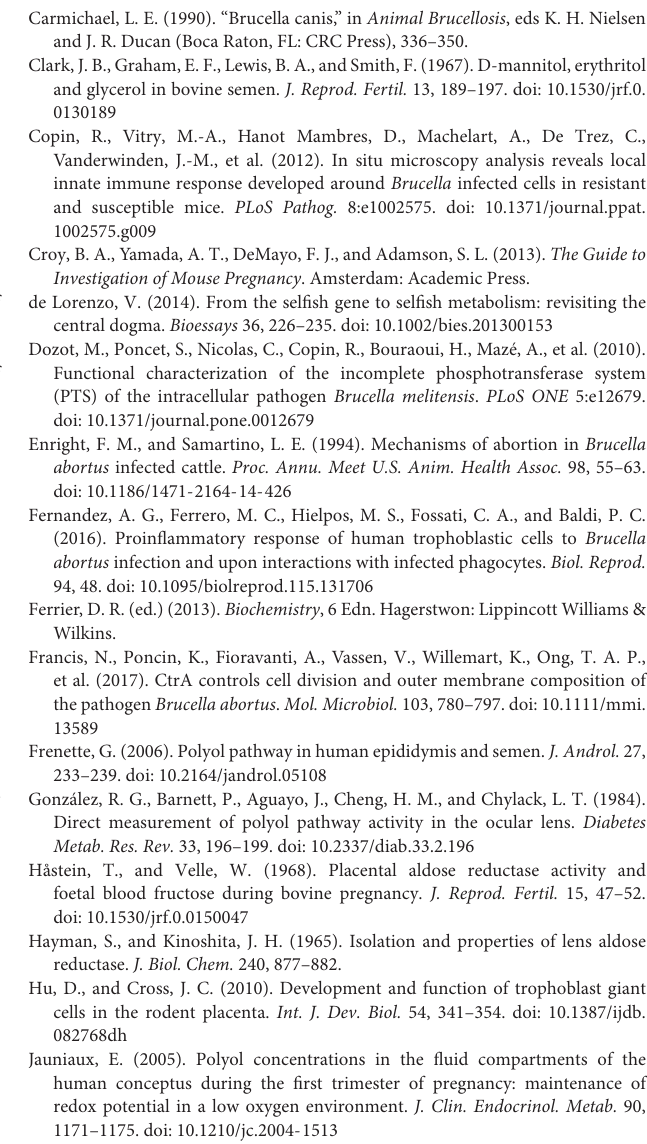
strongly suggesting that the toxicity is specific for erythritol. The experiment was performed in biological triplicates and technical duplicates. Values represent the average of one representative experiment ± standard deviation (shaded gray and dashed lines). FIGURE S3 | Aldose reductase localization in the spleen of mice infected with B. abortus 2308. Mice were infected intraperitoneally with 10 5 CFU of B. abortus 2308, spleens obtained at day 9 post infection and stained for actin (phalloidin/gray) and CD11b (green). (A) iNOS immunostaining (blue) of spleen sections of non-infected (control, Left), and infected (Br.9d, Right), mice. The red pulp shows small clusters of CD11b-positive cells (often iNOS positive) that correspond to Brucella granulomas {Copin:2012ee}. (B) Aldose reductase immunostaining (purple) of spleen sections of non-infected and infected mice. In the non-infected mice (control, Left), aldose reductase was scarcely detected and was restricted to a few and CD11b-negative cells of the red pulp. In infected mice 9 days post-infection (Br.9d, Right), aldose reductase was abundant in the red pulp in the same areas where the Brucella granulomas